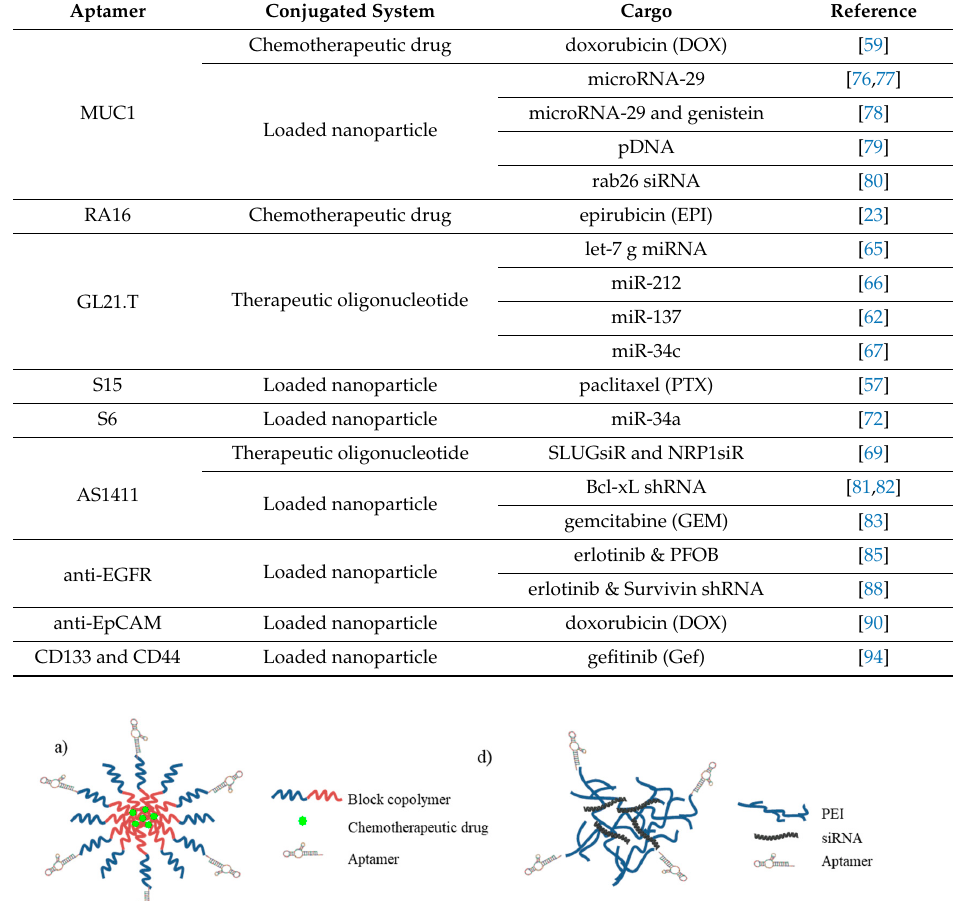
Table 4. Summary of aptamer-based complexes for targeted delivery in NSCLC.